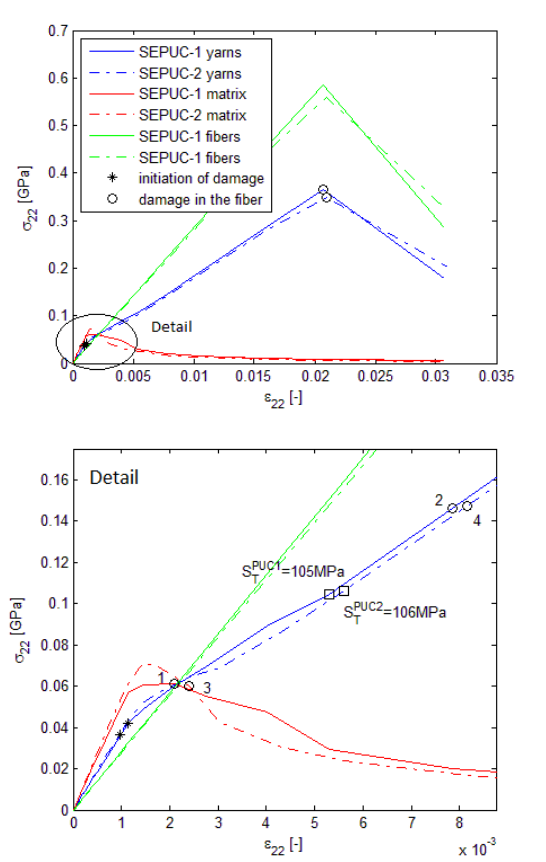
Figure 7. Stress-strain curves under the macroscopic tensile strain in the second transverse